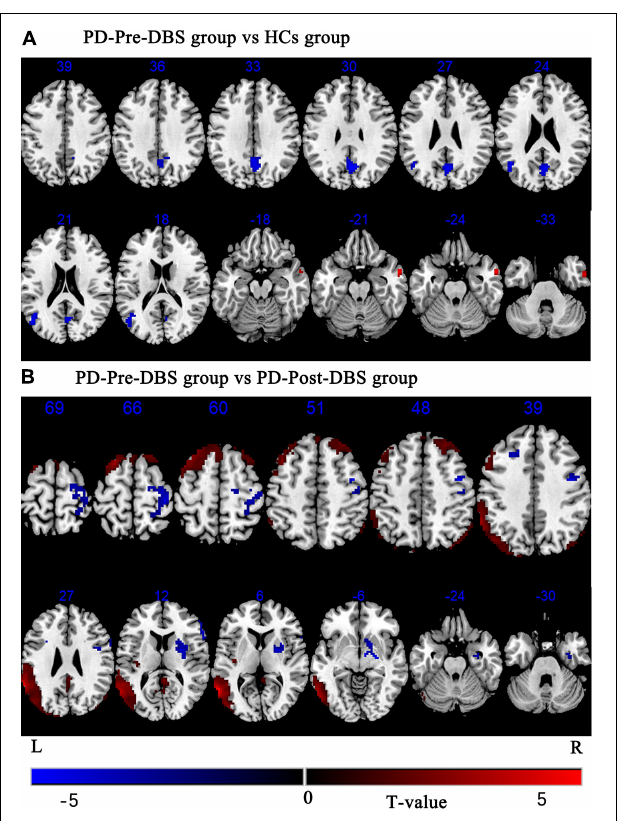
FIGURE 1 | Brain regions with altered ALFF between the PD-Pre-DBS group and HCs, the PD-Pre-DBS group and the PD-Post-DBS group were shown in (A) (PD-Pre-DBS group vs HCs group) and (B) (PD-Pre-DBS group vs PD-Post-DBS group), respectively. Regions showing increased ALFF in red and decreased ALFF in blue; L and R represent left and right hemispheres, respectively; The results were corrected by multiple comparisons of the family-wise error (FWE) (voxel p < 0.001, cluster p < 0.05); ALFF, amplitude of low-frequency fluctuation; PD-Pre-DBS, three days before DBS, PD-Post-DBS, one day after DBS, each time in the off medication and absence of neurostimulation; PD, Parkinson’s disease; DBS, deep brain stimulation; vs,